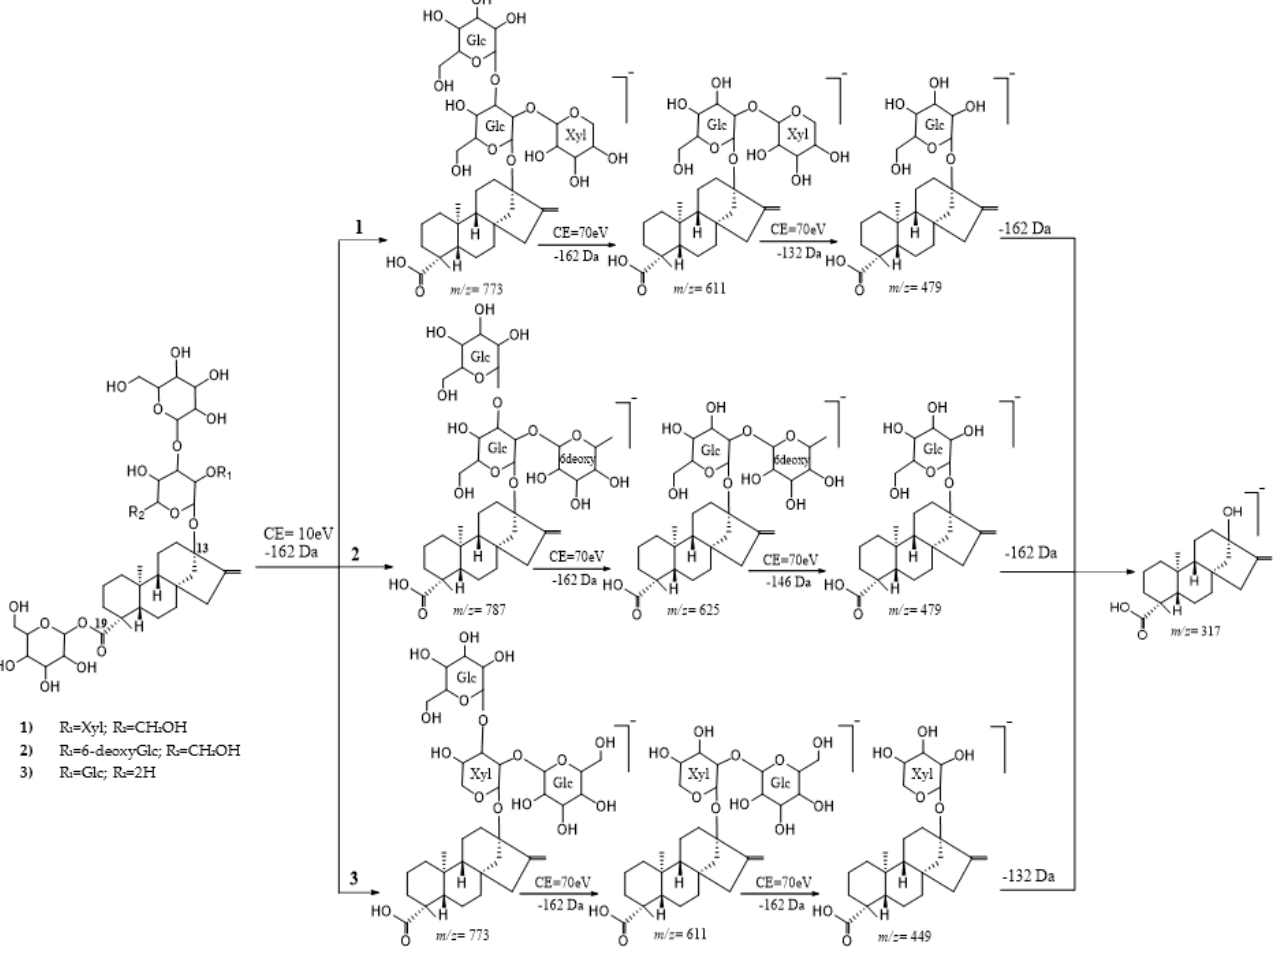
Figure 5. Fragmentation pattern of steviol glycosides.